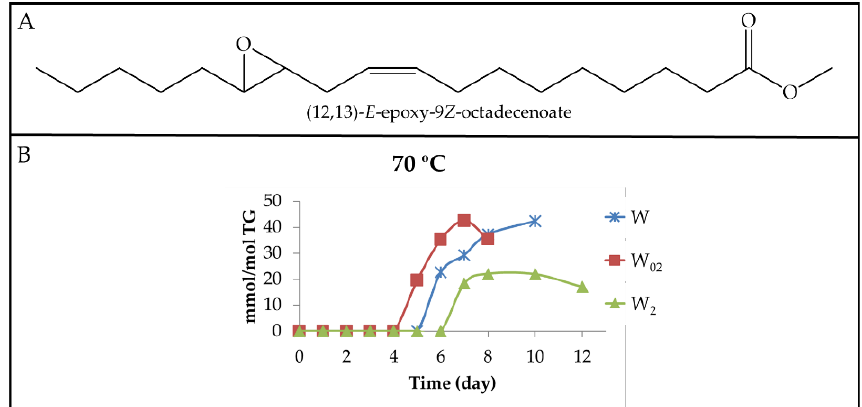
Figure 18. ( A ) Structure of (12,13)- E -epoxy-9 Z -octadecenoate as an example of E -mEPO- Z -mE. ( B ) Evolution of the concentration expressed as mmol/mol TG, of E -mEPO- Z -mEs in walnut oil with different enrichment levels of α T (W, W 02 and W 2 ), submitted to 70 ◦ C up to advanced stages of the oxidation process.